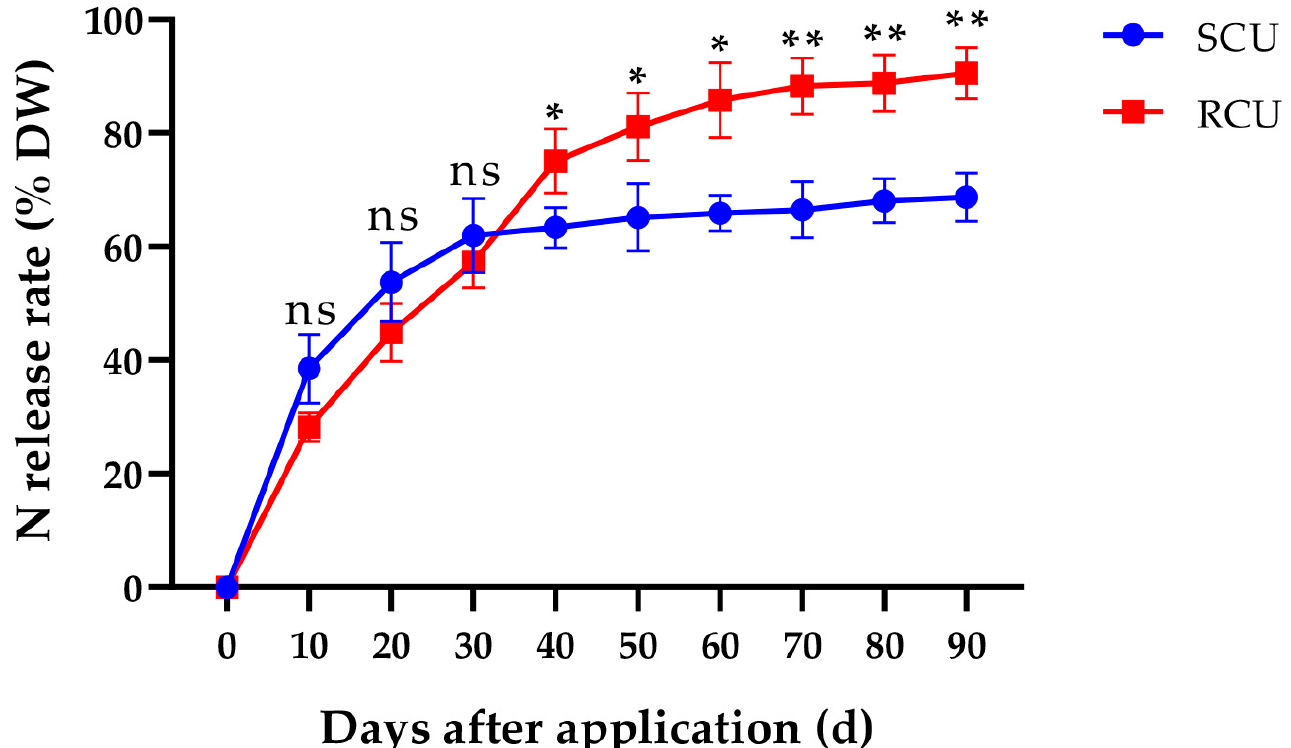
Figure 1. Nitrogen release rates of SCU and RCU in the pool. (ns) means not significant. (*) represents p values of < 0.05 and is considered statistically significant. (**) represents p values of < 0.01 and is considered highly statistically significant. Error bars show the standard deviation (SD) from three biological replicates.